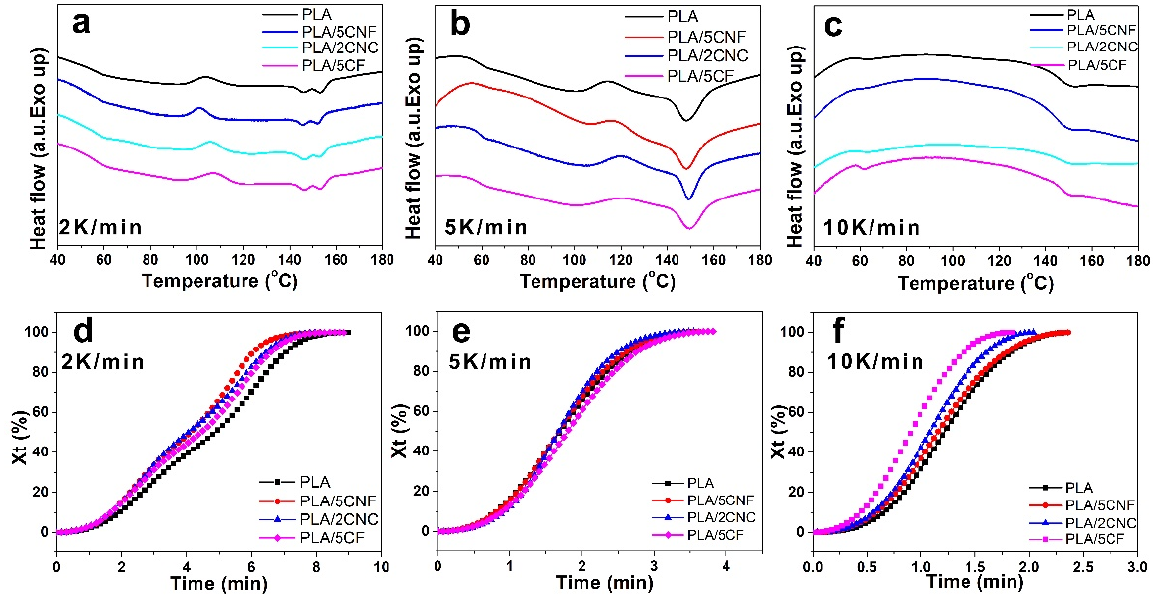
Figure 6. DSC curves of PLA film and composite films at different heating rates: 2 K/min ( a ), 5 K/min ( b ), and 10 K/min ( c ); Elative crystallinity curves for PLA film and composite films at different rates: 2 K/min ( d ), 5 K/min ( e ), and 10 K/min ( f ), respectively.